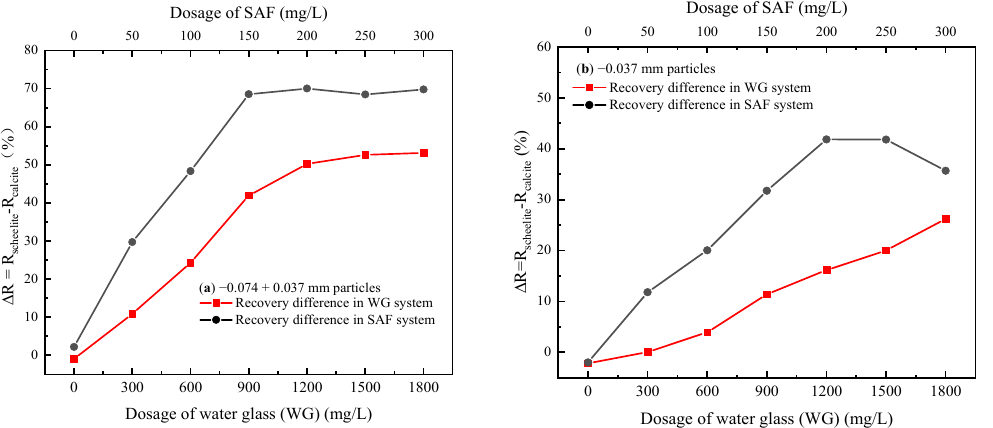
Figure 6. Recovery difference of ( a ) − 0.074 + 0.037 mm ( b ) − 0.037 mm particles in different depressant systems with 50 mg/L NaOL at pH 9.